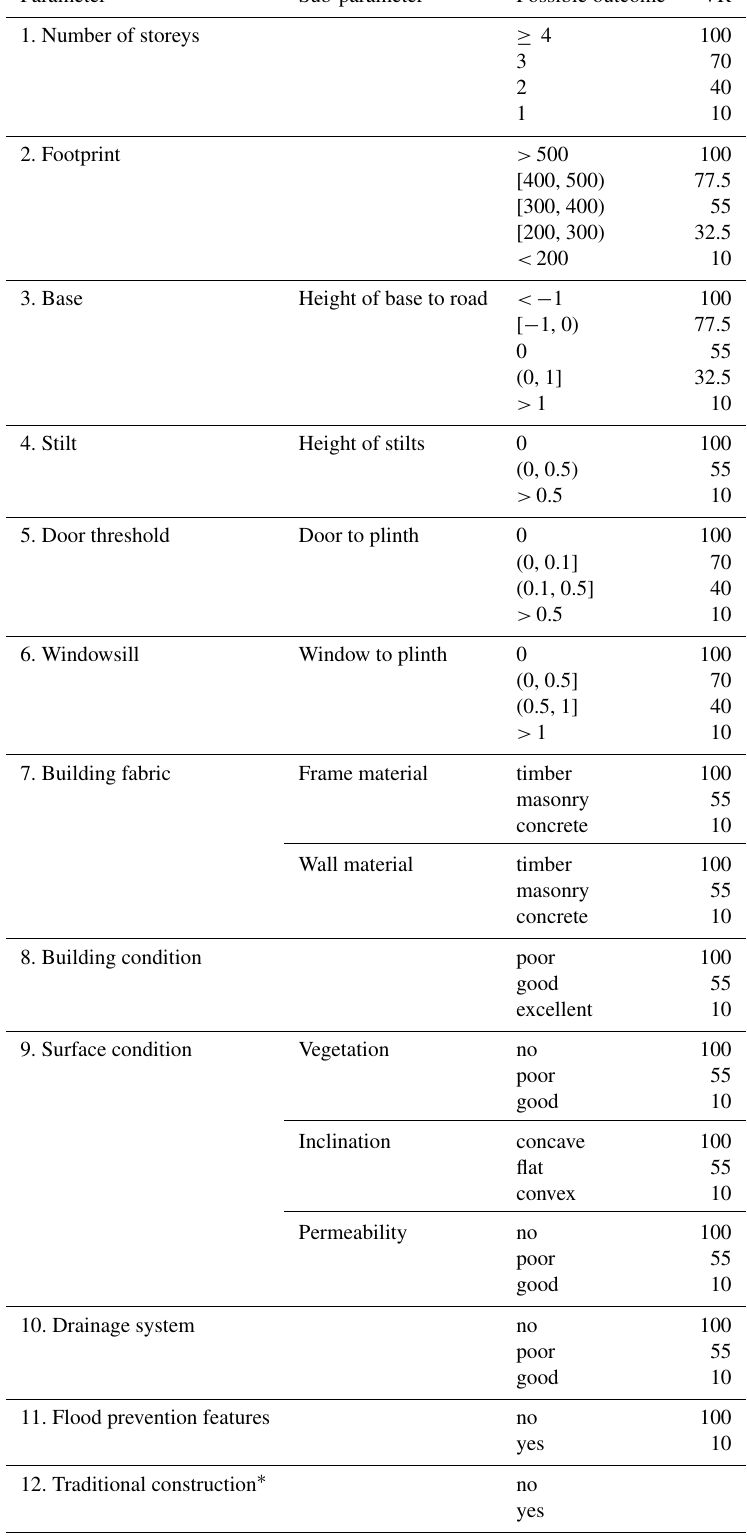
Table 3. Parameters’ attributes and corresponding vulnerability rating in PARNASSUS v.3.